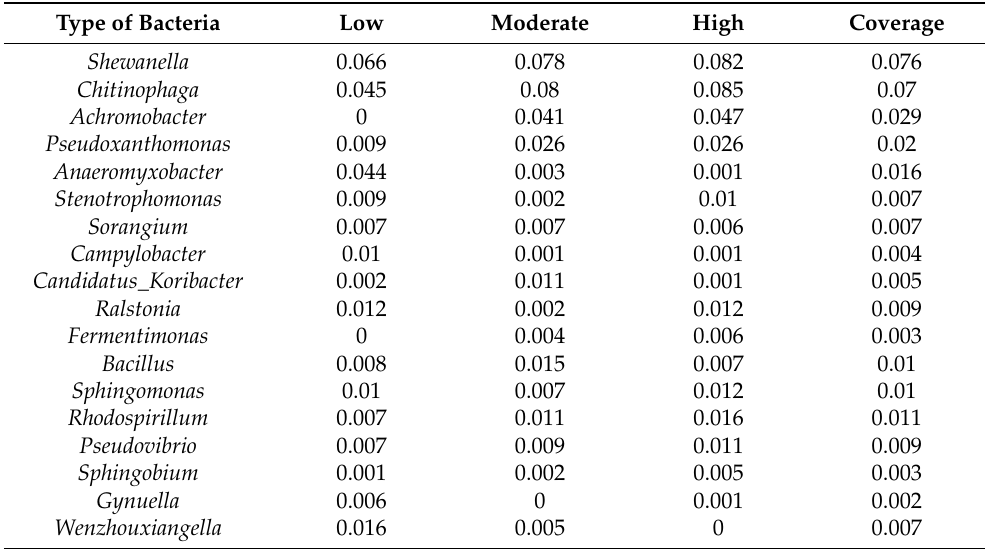
Figure 3. Effects of moso bamboo invasion on denitrifying bacterial community composition. Barplots showing the denitrifying bacterial community composition at class ( A ) and genus ( B ) levels. Table 2. The relative abundance of dominant denitrifying bacteria in the rhizosphere of three sites.